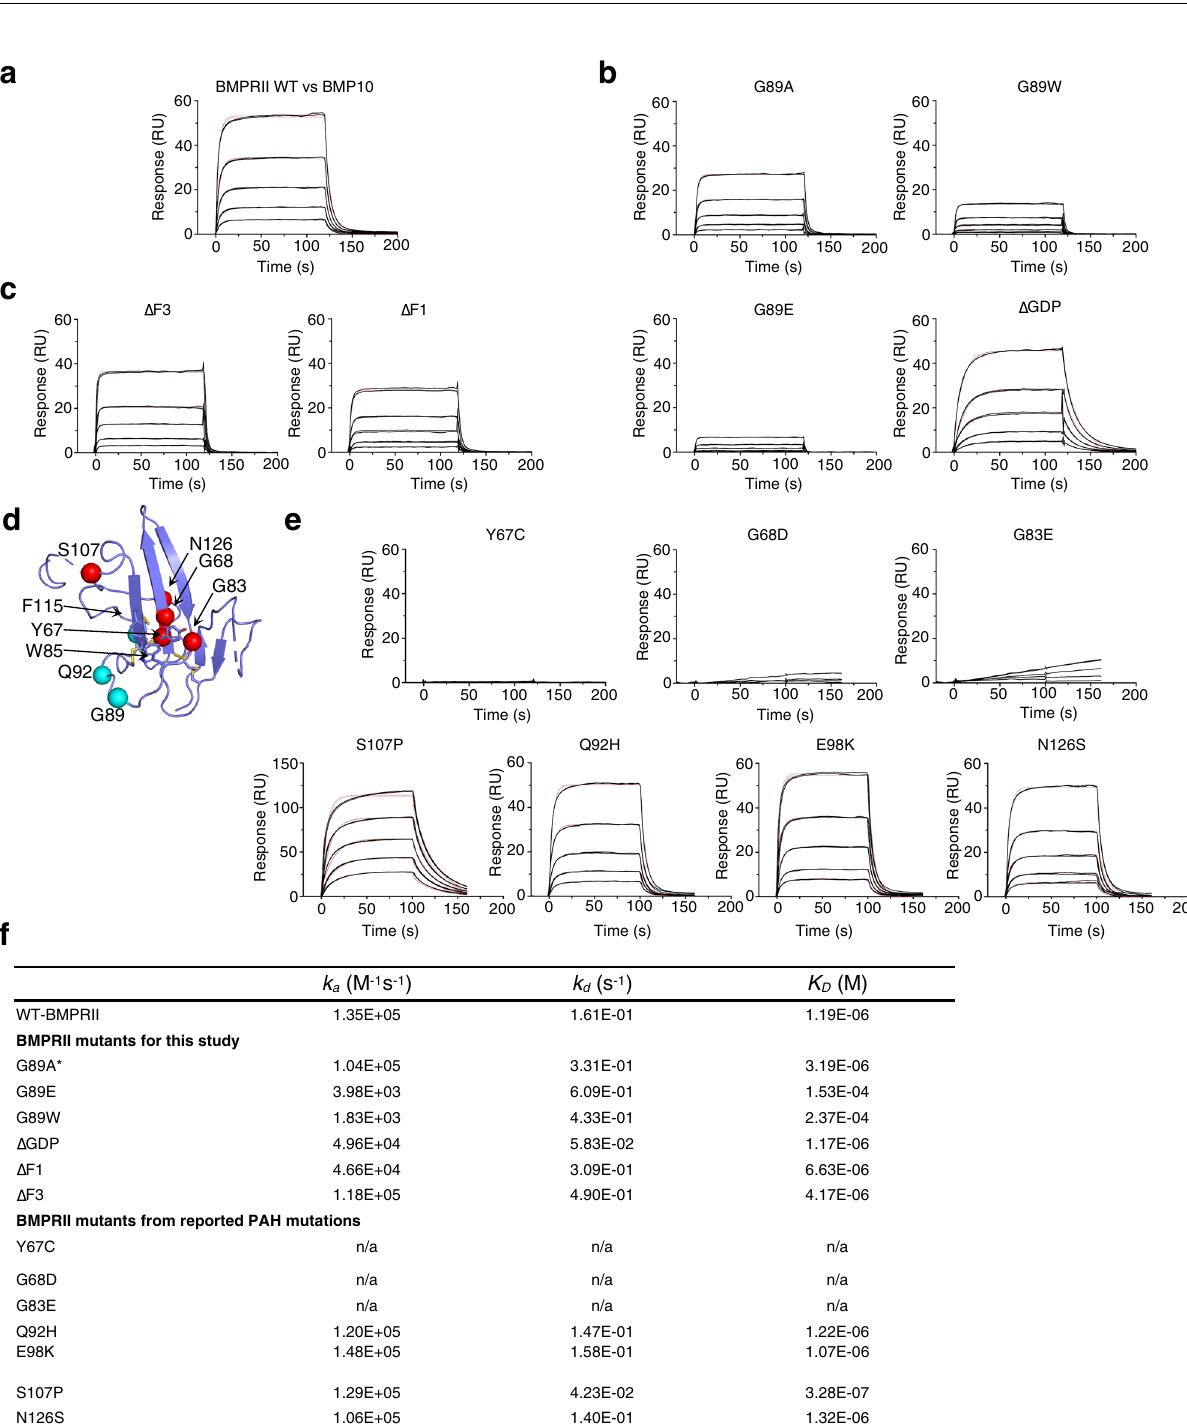
NATURE COMMUNICATIONS| (2022) 13:2395